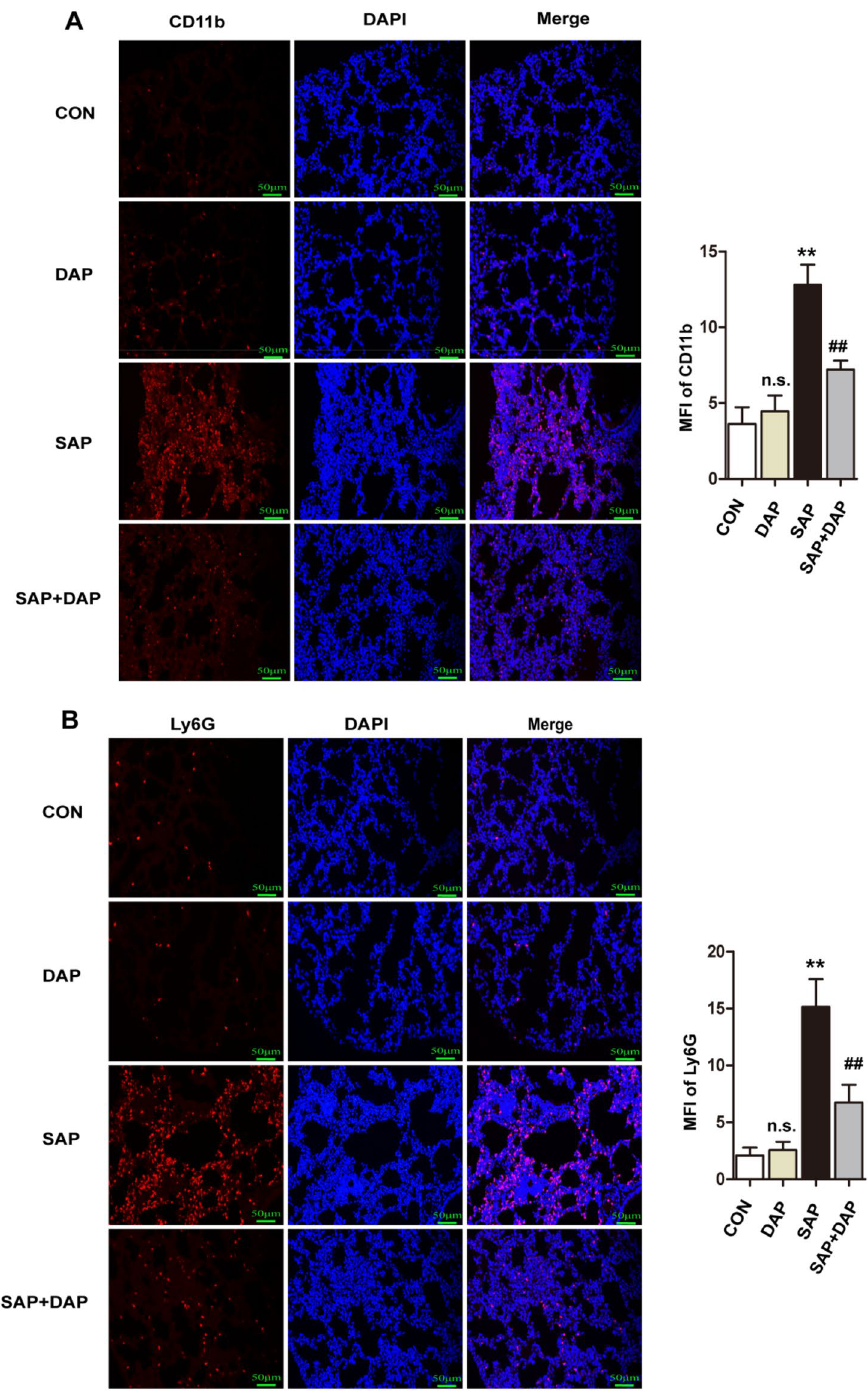
Figure 3. Daphnetin pretreatment inhibited the infiltration of macrophages and neutrophils. Representative images of immunofluorescence detection of the macrophages markers CD11b ( A ) and the neutrophil marker Ly6G ( B ) in the lung tissues. Nuclei were counterstained with DAPI. The results for the quantitation of mean fluorescence intensity (MFI) in the red channel are presented. The histograms were created using GraphPad 5 software(GraphPad Prism 5.01 http:// www. xdowns. com/ soft/ xdown s2009. asp? softid= 49668 & downid= 60& id= 52443). The quantitative analysis of immunostaining was used by ImageJ software(Image J 2 system software https:// imagej. net/ Downl oads). CON group, l-arginine vehicle + daphnetin vehicle; SAP group, l-arginine + daphnetin vehicle; DAP group, l-arginine vehicle + daphnetin; SAP + DAP group, l-arginine + daphnetin. Data are presented as the mean ± SD. n = 6 /group. **P < 0.01 vs. CON group. ## P < 0.01 versus SAP group, n.s. P > 0.05 versus CON group. Scale bars: 50